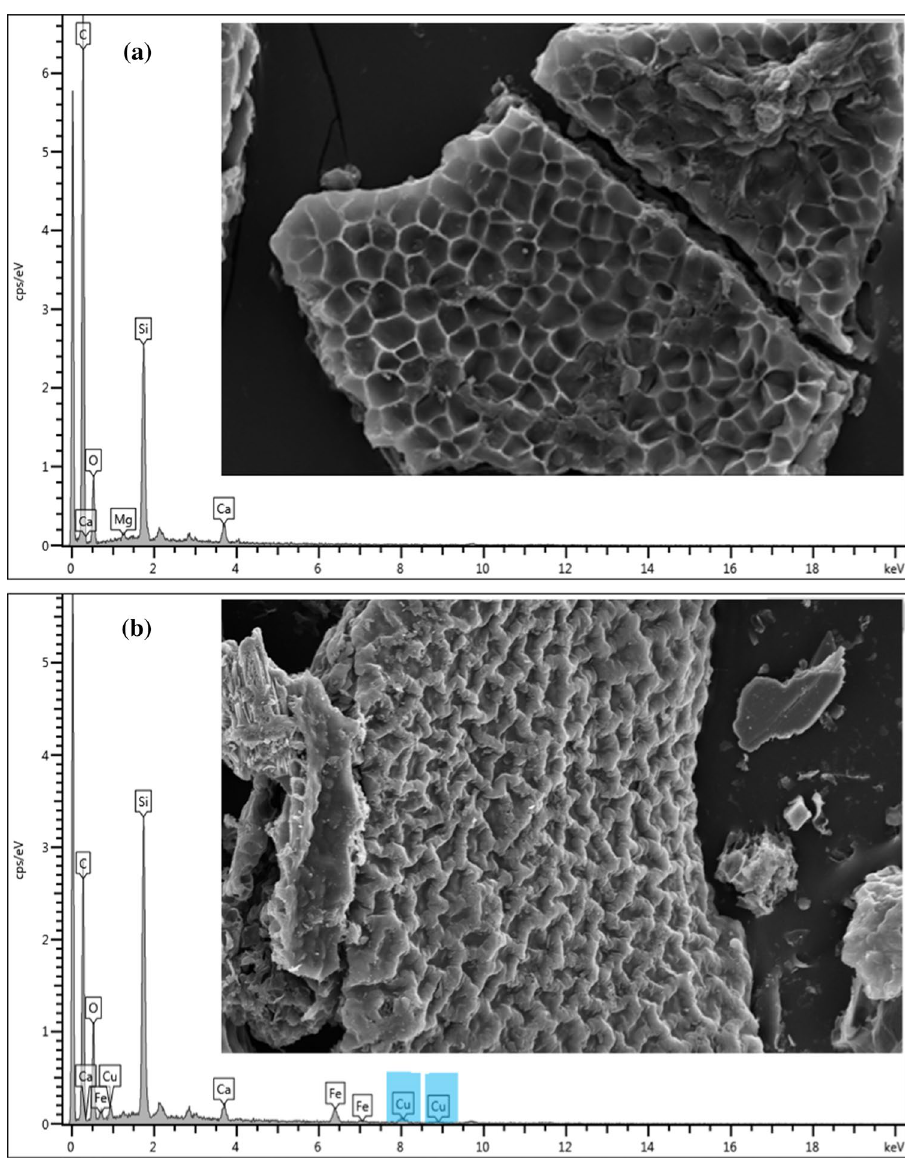
bent. a AC and b Cu-impreg- nated